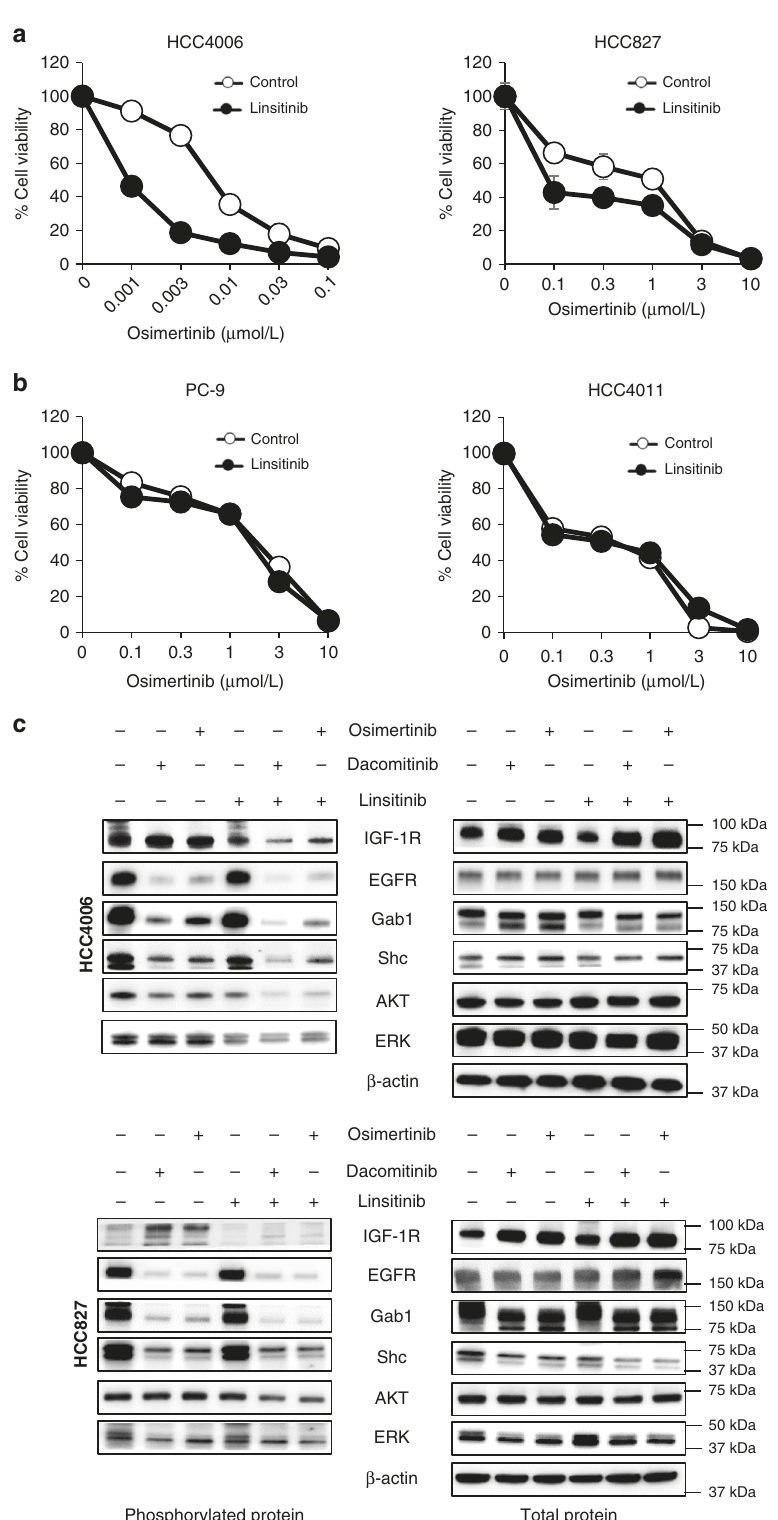
Fig. 5 IGF-1R inhibitor inhibited the viability of AXL-low tumor cells exposed to osimertinib. AXL-low expressing ( a ) and AXL-high expressing ( b ) EGFR - mutated NSCLC cell lines were treated with various concentrations of osimertinib for 72 h in the presence or absence of linsitinib (1 μ mol/L), and cell viability was determined. The percentage of growth is shown relative to untreated controls. Data are presented as mean ± s.d. Each sample was assayed in triplicate, with each experiment repeated at least three times independently. c HCC4006 and HCC827 cells were treated with osimertinib (30 and 300 nmol/L, respectively), dacomitinib (30 and 300 nmol/L, respectively), and/or linsitinib (1 μ mol/L). After 72 h, the cells were lysed, and the indicated proteins were detected by western blotting. Data shown are representative of three independent experiments. Bars indicate